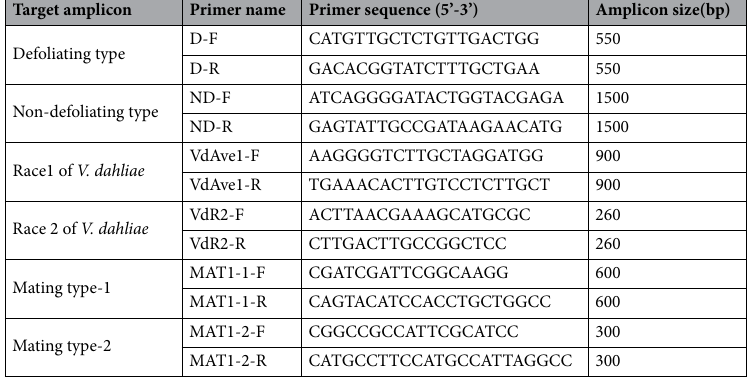
Table 1. Primers used in this study. Primer pairs: Defoliating type (D-F/D-R), Nondefoliating type (ND-F/ ND-R), V. dahliae Ave1 gene (VdAve1-F/VdAve1-R), V. dahliae race 2 (VdR2-F/VdR2-R), Mating type-1